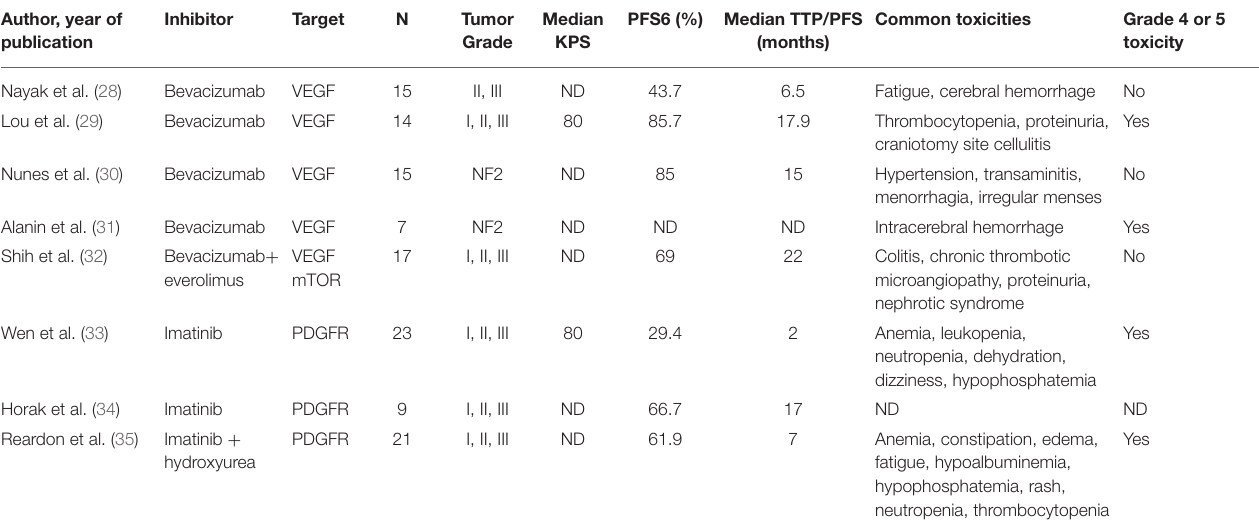
TABLE 6 | Targeted therapy for progressive recurrent